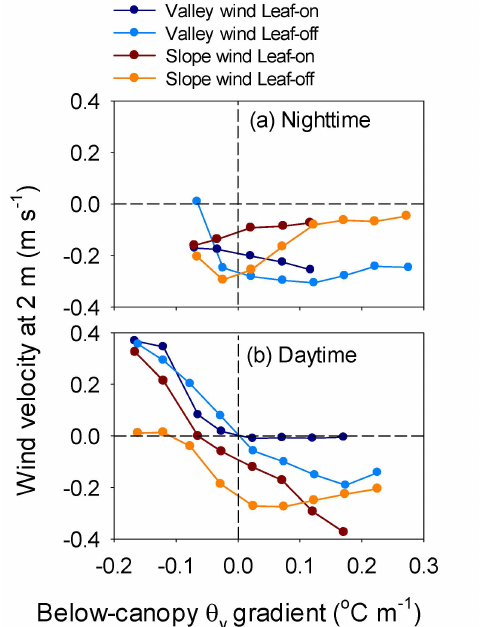
Figure 15. Change of mean velocity of valley and slope winds at the 2 m with the gradient of below-canopy virtual potential air temperature ( θ v ) in the nighttime ( a ) and daytime ( b ) in